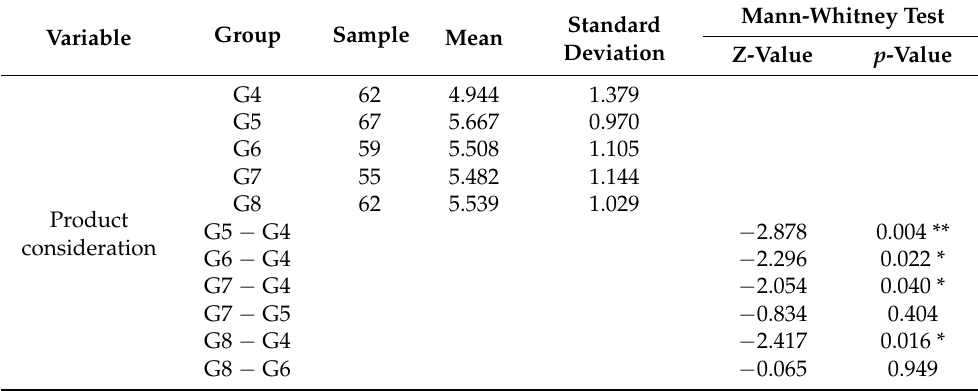
Table 11. Test results of differences in product consideration under different